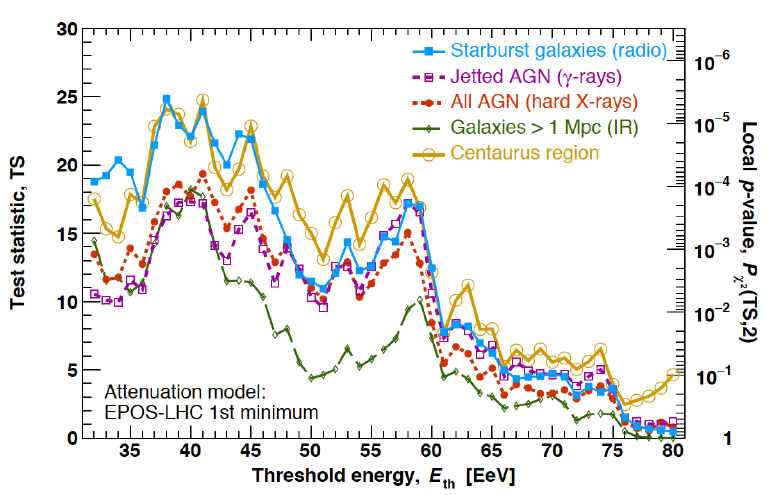
Figure 3. Significance (test statistic) of the search for UHECR anisotropies as a function of threshold energy (in EeV) against four, complementary catalogs, including jetted AGNs and starburst galaxies (SBGs), along with the results for the Centaurus region. In general, the AGN catalogs are dominated by a contribution from Cen A, while the SBGs M83 and NGC 4945 in the Centaurus region feature prominently in the SBG model. From ref.